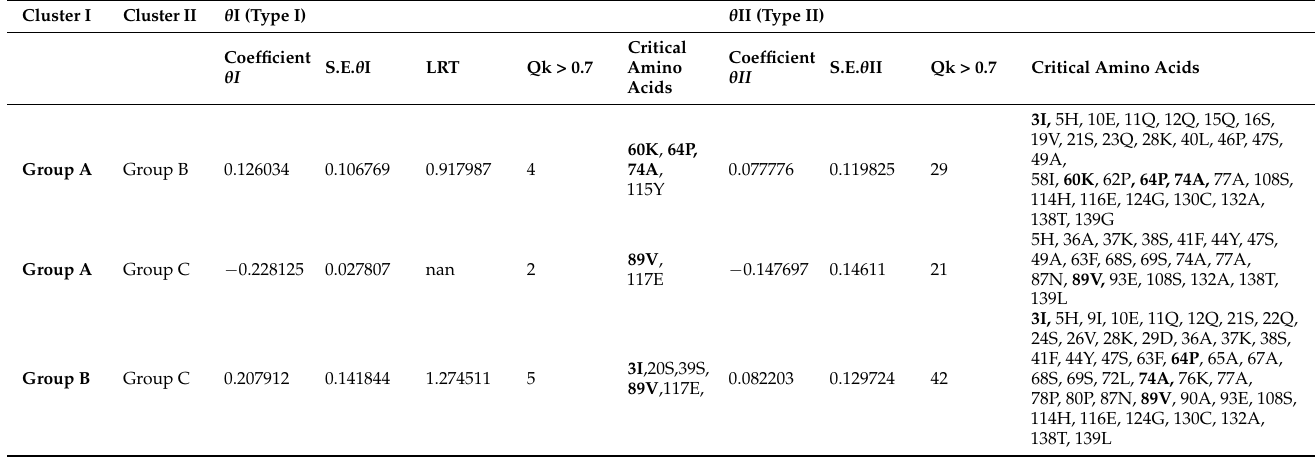
Table 2. Functional divergence prediction between groups of the BnaCRK gene